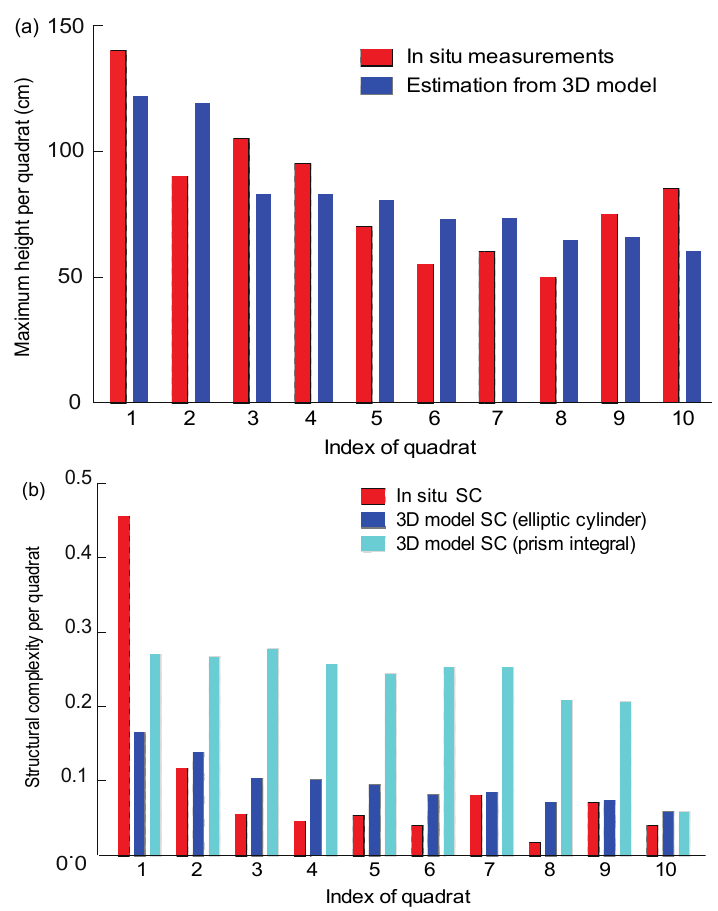
Figure 5. ( a ) Comparison between the maximum height for quadrats 1–10: in situ measurements (black), estimations from 3D reconstructed model (grey); and ( b ) comparison between the structural complexity for quadrats 1–10: in situ measurements (black), 3D reconstructed model, which assumes simple geometric forms (grey) and the underwater 3D reconstructed model, which takes into account the actual shape (light grey). Structural complexity was calculated as in Equation (1), where a value of 1 represents a highly complex quadrat and a value of 0 a flat quadrat.